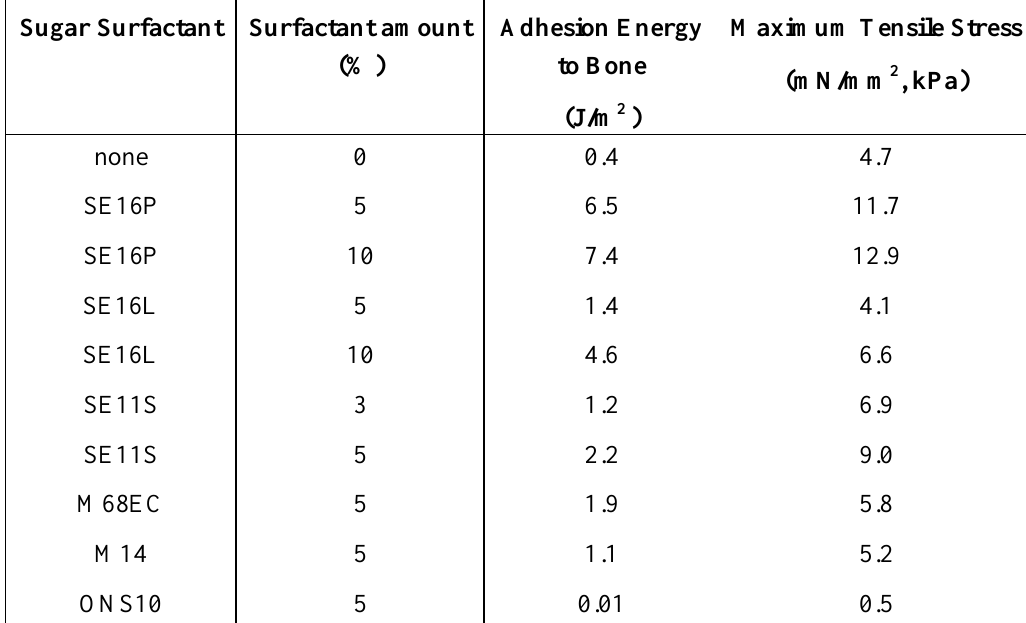
Table 3. Adhesion energy to bone of cement pastes with the different sugar surfactants. Sugar